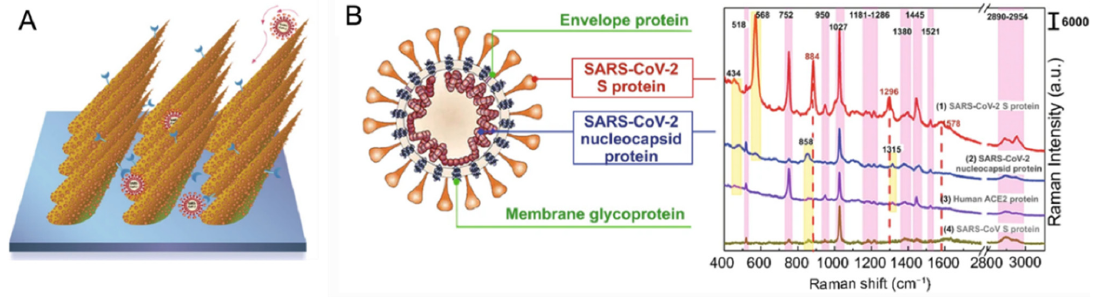
Figure 10. Gold-nanoneedles array and SERS spectra of viral protein. ( A ) Schematics of “virus- traps” nanoforest composed of tilted gold-nanoneedles array. ( B ) Structure schematics of SARS-CoV-2 ( left ), and SERS spectra ( right ) of SARS-CoV-2 S protein and nucleocapsid protein, SARS-CoV S protein, and Human ACE2 protein [109].